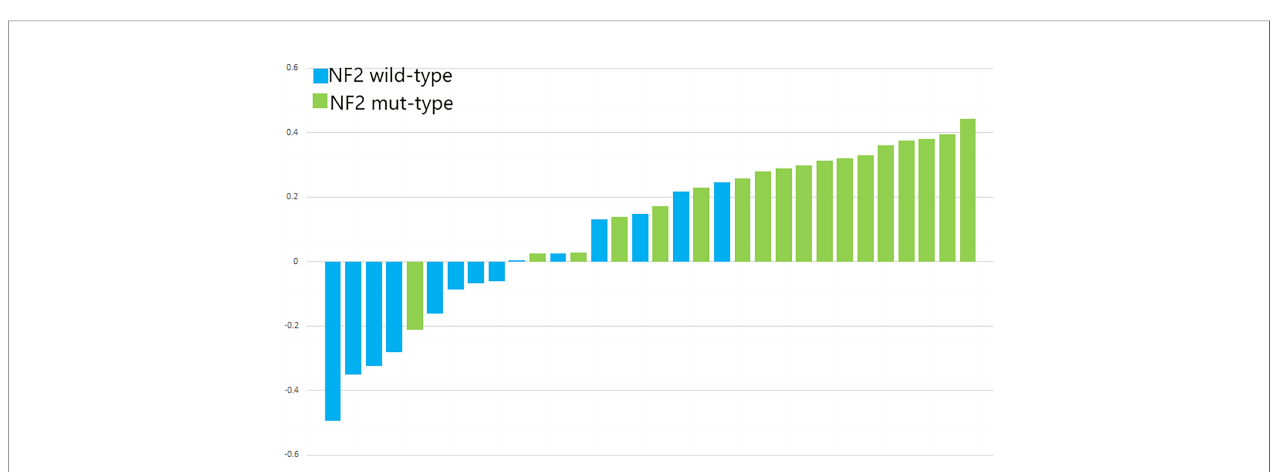
FIGURE 7 | The p-values of SVM for the validation cohorts. The blue bars show the radiomics signature values for the NF2 -wild meningiomas, and the green bars show the values for the NF2 -mut